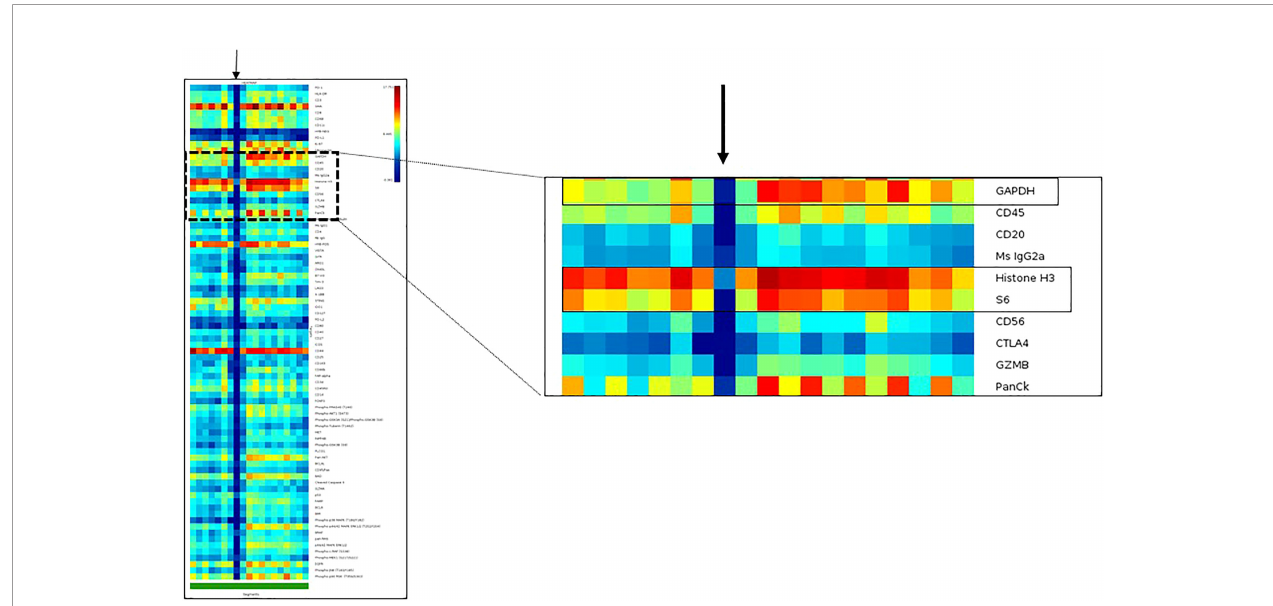
FIGURE 6 | Heatmap of an initial dataset obtained with DSP assay to illustrate the visualization of data as quality control tool. The DSP counts of one region of interest indicated with a black arrow show no or very low DSP counts from all targets of the DSP protein panel, including the housekeeper proteins: GAPDH, Histone3 and S6. The DSP quality control report showed a positive control normalization tag in this speci fi c region of